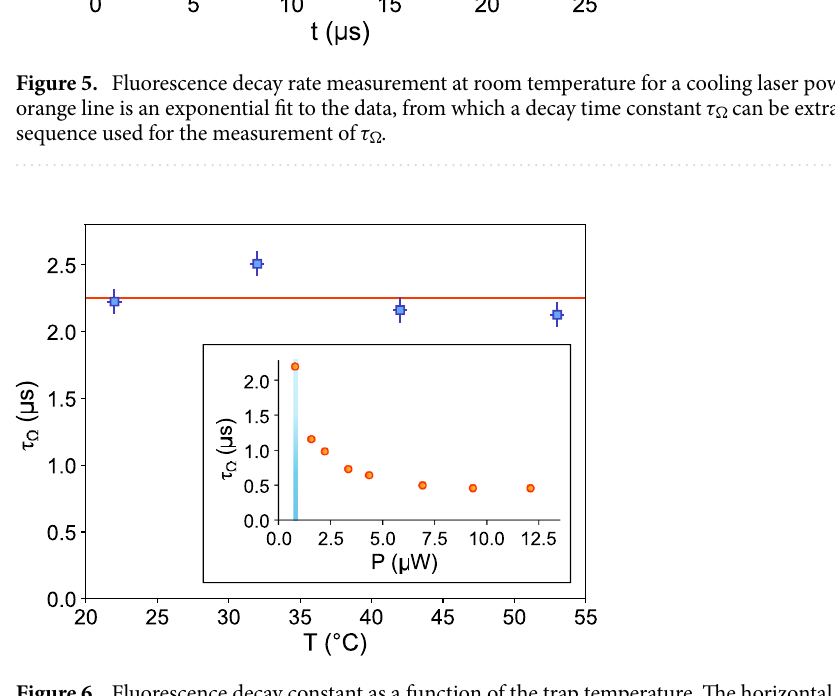
Figure 6. Fluorescence decay constant as a function of the trap temperature. The horizontal orange line is the averaged τ � between all the measurements. The horizontal error bars represent the statistical error on reading the temperature using the three different thermal sensors. The vertical error bars combine the statistical error in the fit for τ � and the error in determining the laser power P times the slope of the τ � vs. P curve. Inset: ◦ fluorescence decay constant as a function of laser power measured at 22 C. The shaded blue area denotes the power range at which the data in the main figure were